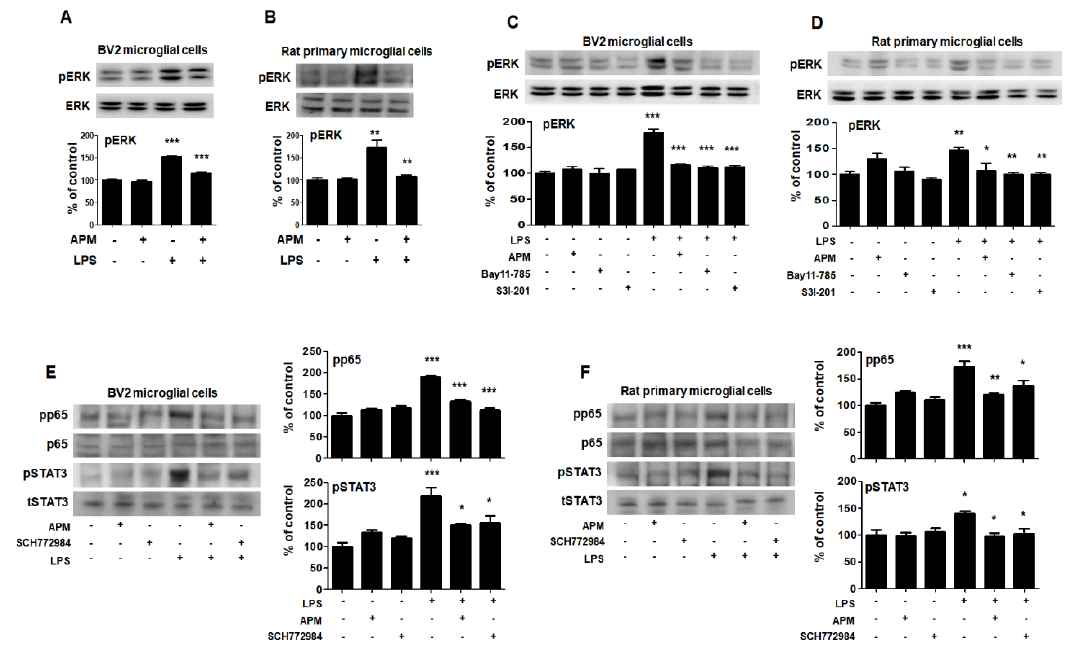
Figure 5. APM inhibits LPS-induced MAPK-ERK phosphorylation and interaction of MAPK-ERK and p65 / STAT3 in BV2 and rat primary microglial cells. Cells were treated with APM for 1 h followed by LPS for 6 h. LPS-induced MAPK-ERK phosphorylation was inhibited by APM administration in BV2 ( A ) and rat primary microglial cells ( B ). Inhibitors of NF- κ B (10 µ M Bay11-7085), STAT3 (10 µ M S3I-201) or APM strongly suppressed LPS-induced MAPK-ERK phosphorylation in BV2 ( C ) and rat primary microglial cells ( D ). MAPK-ERK inhibitor (10 µ M SCH772984) or APM e ff ectively suppressed LPS-induced p65 and STAT3 phosphorylation in BV2 ( E ) and rat primary microglial cells ( F ). β Actin was used to confirm equal sample loading. pERK, pp65, and pSTAT3 followed by densitometric analysis. The data are representative of three independent experiments and quantified as mean values ± SEM. Tukey’s multiple comparison test, * p < 0.05, ** p < 0.01, *** p < 0.001 compared to normal control.